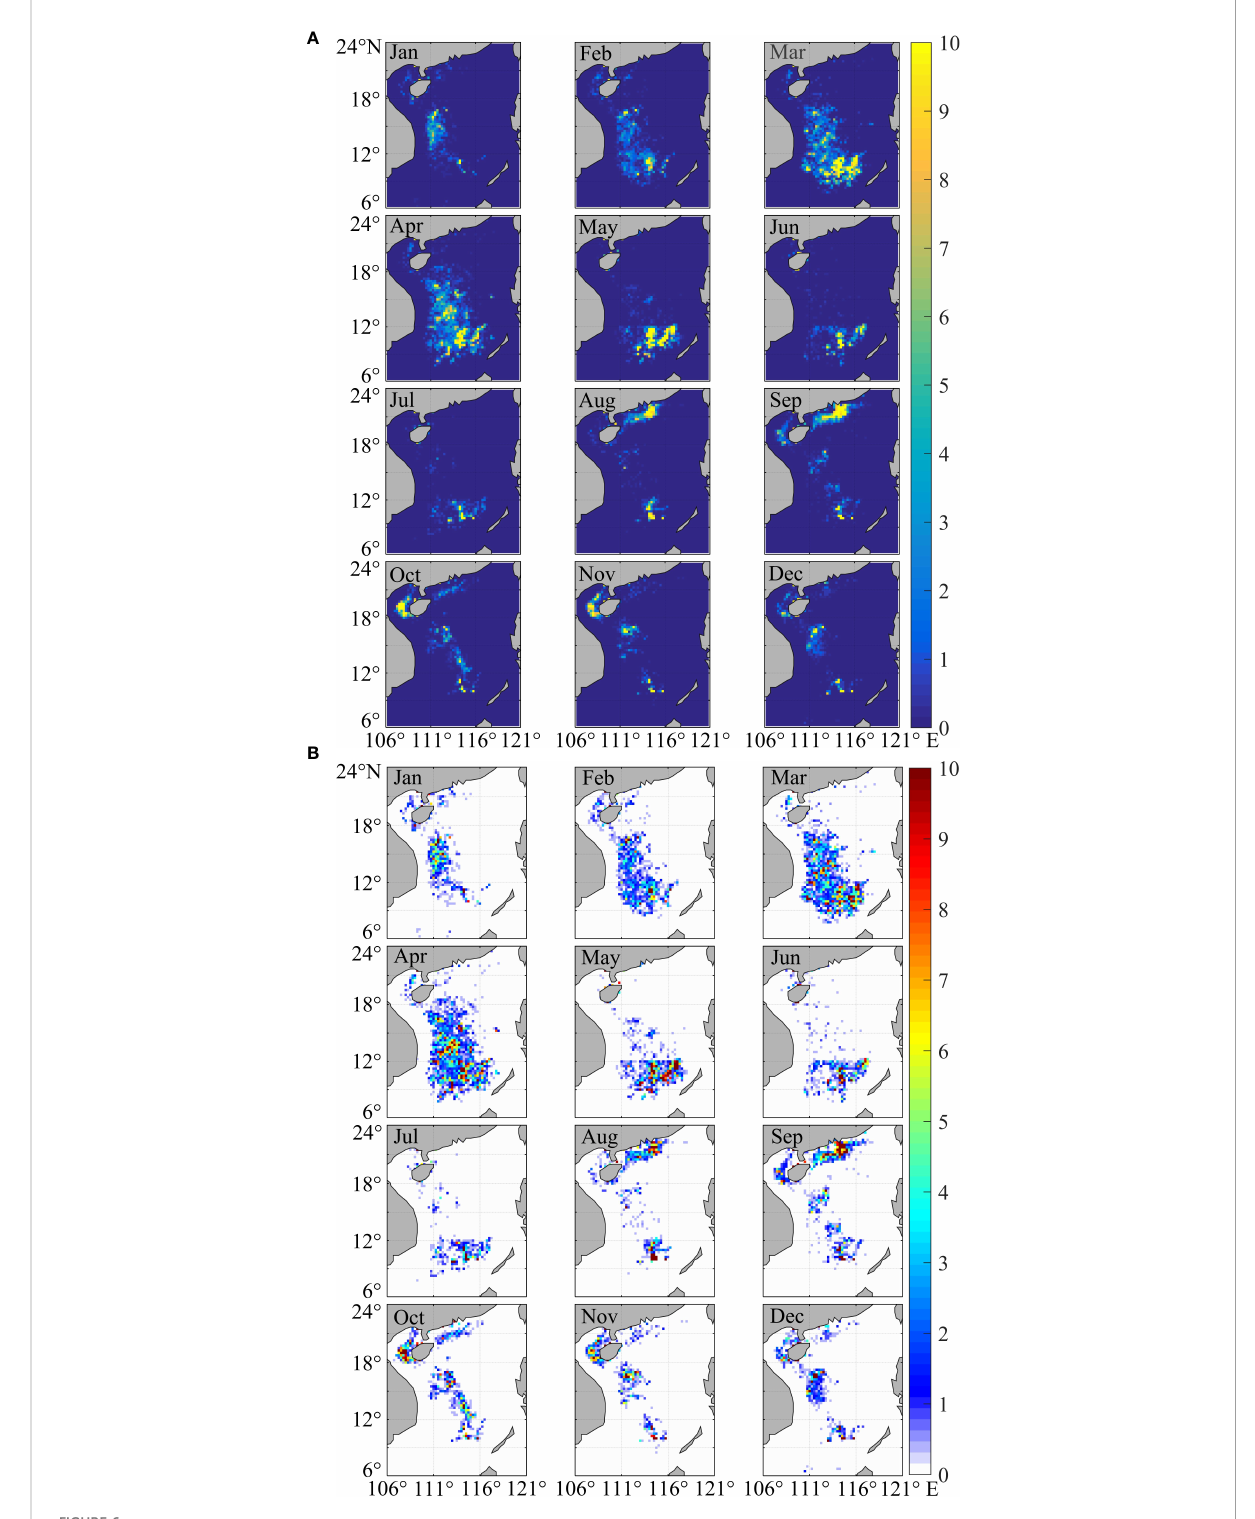
FIGURE 6 Monthly average distribution (A) and standard deviation distribution (B) of large-size light falling-net vessels in the South China Sea from 2017 to